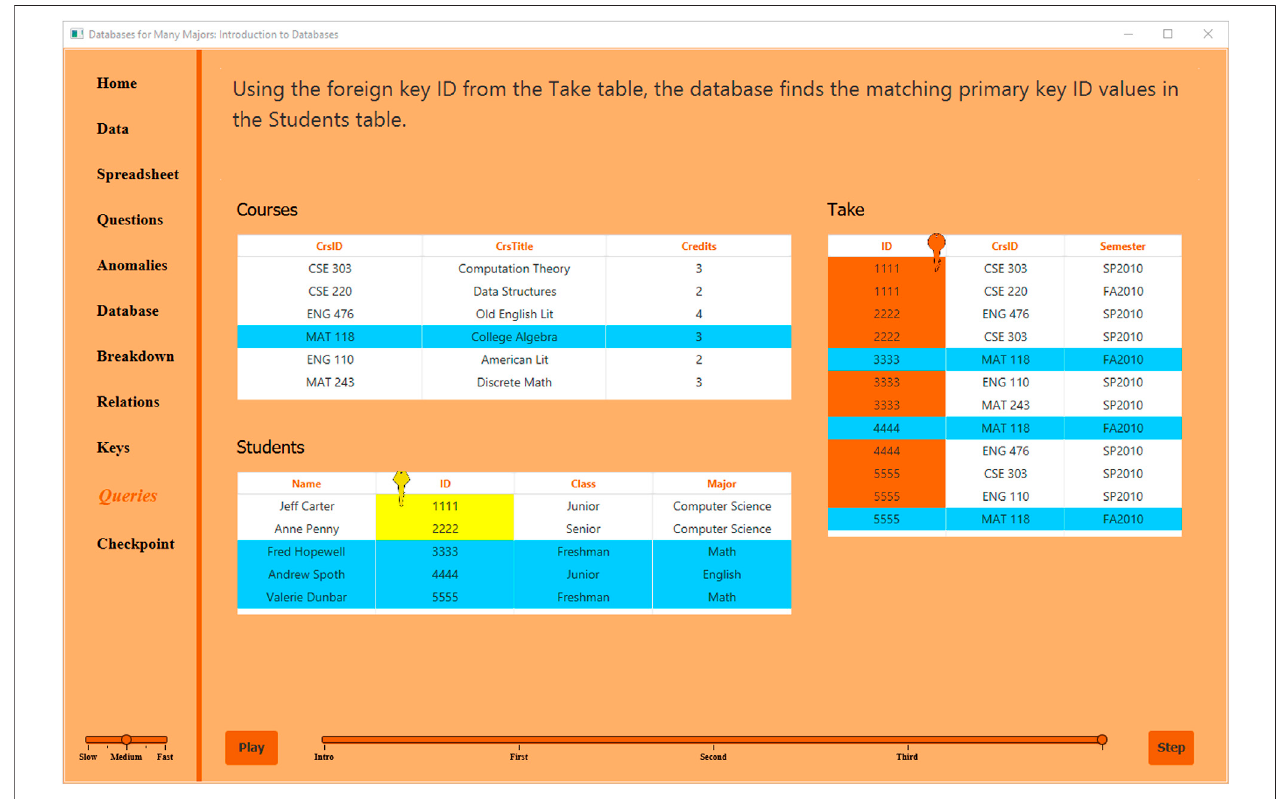
FIGURE 1 | IntroDB queries for default student taking courses (STC)